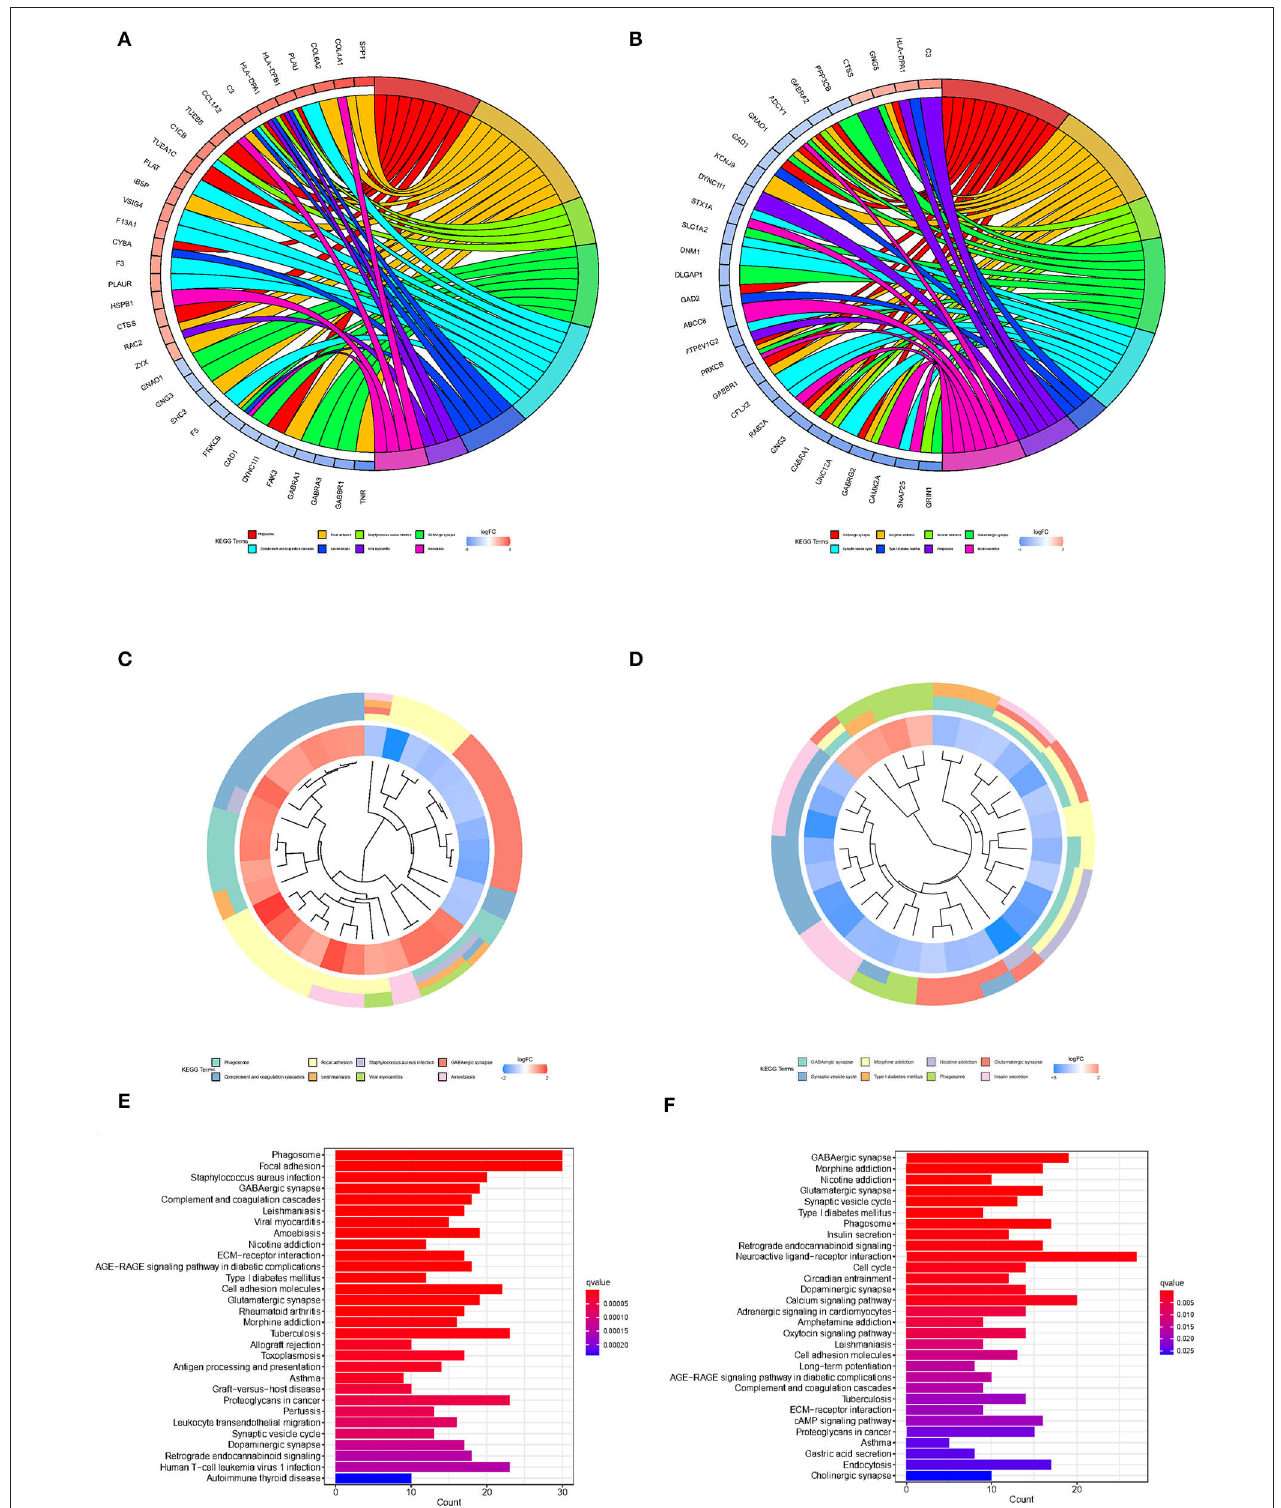
FIGURE 4 | Analyses of differentially expressed genes between two clusters using the Kyoto Encyclopedia of Genes and Genomes (KEEG). (A, C, E) KEGG analysis for functional annotation of differentially expressed genes in two clusters of the TCGA database. (B, D, F) KEGG analysis for functional annotation of differentially expressed genes in two clusters of the GSE4412 data